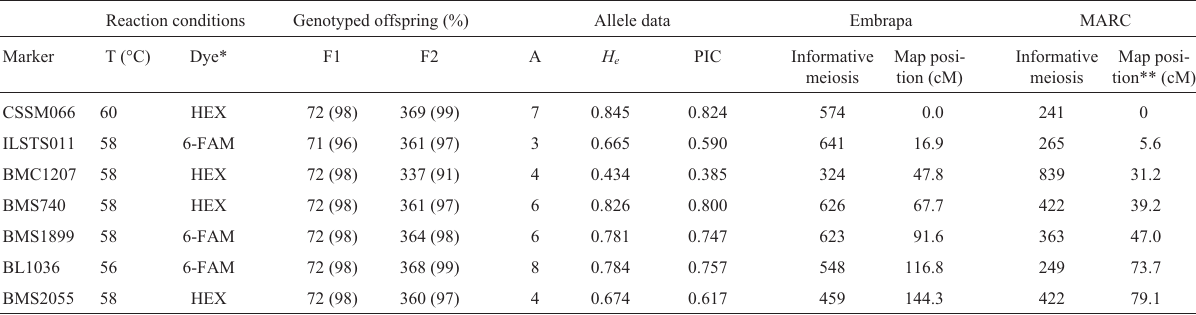
Table 1 - Microsatellite markers, annealing temperature (T), fluorescent dye (Dye), number and percentage of F1 and F2 offspring genotyped, number of alleles (A), expected heterozygosity ( H e ), polymorphism information content (PIC) and informative meiosis comparing the maps produced by the